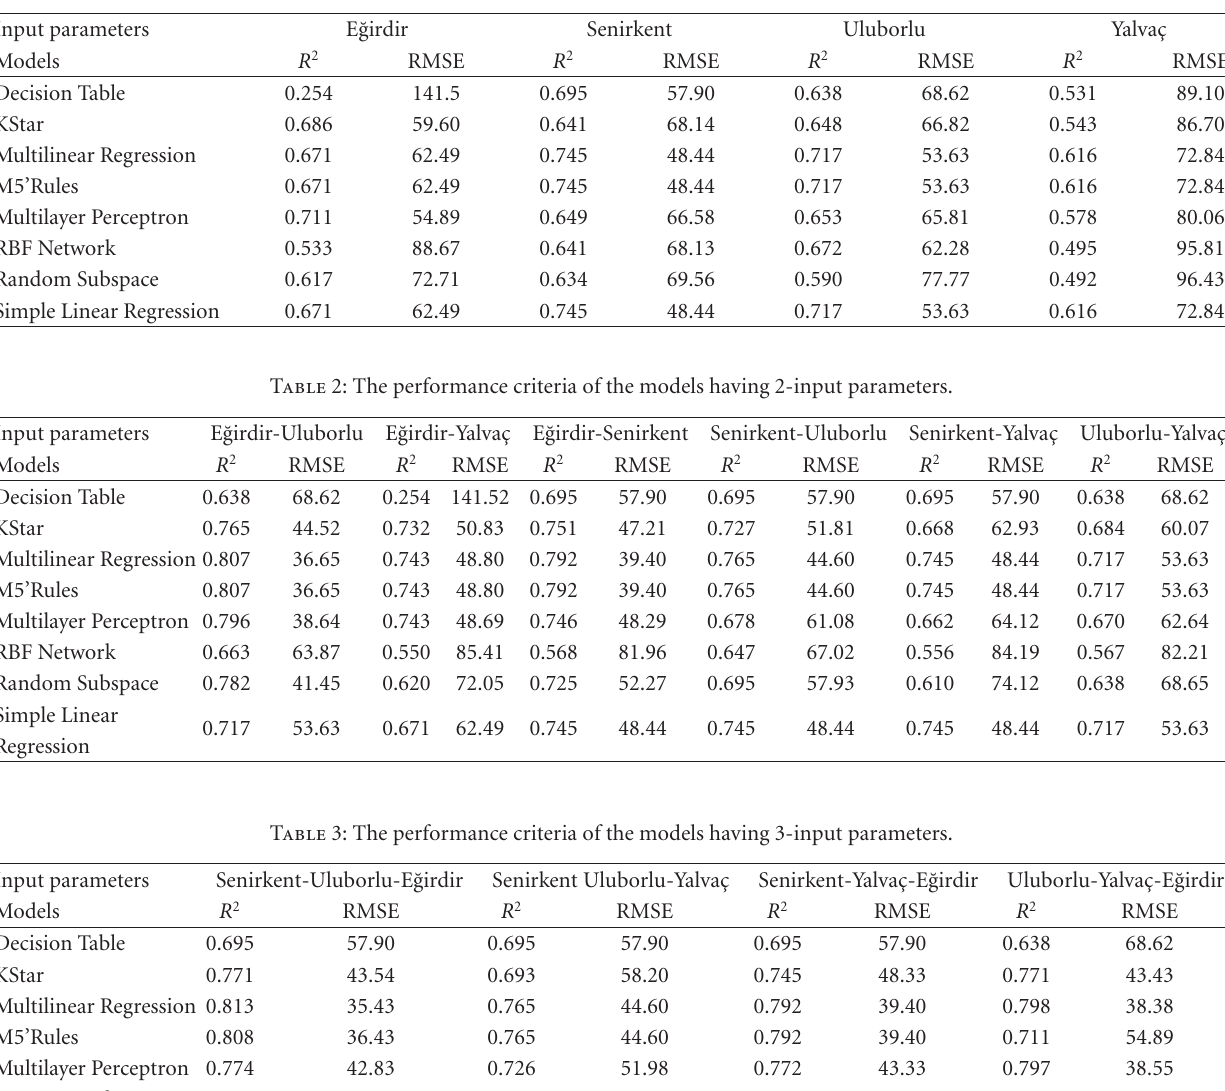
Table 1: The performance criteria of the models having 1-input parameter.